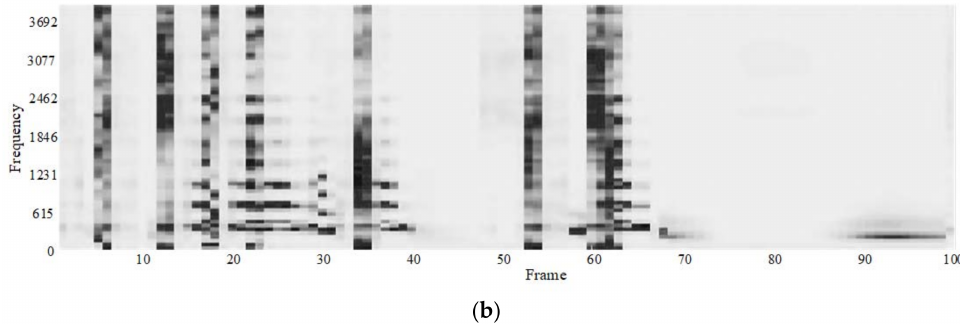
Figure 14. Spectrograms of recovered speech signal using different numbers of hidden layers of DNN ( a ) 4 hidden layers, ( b ) 7 hidden layers.